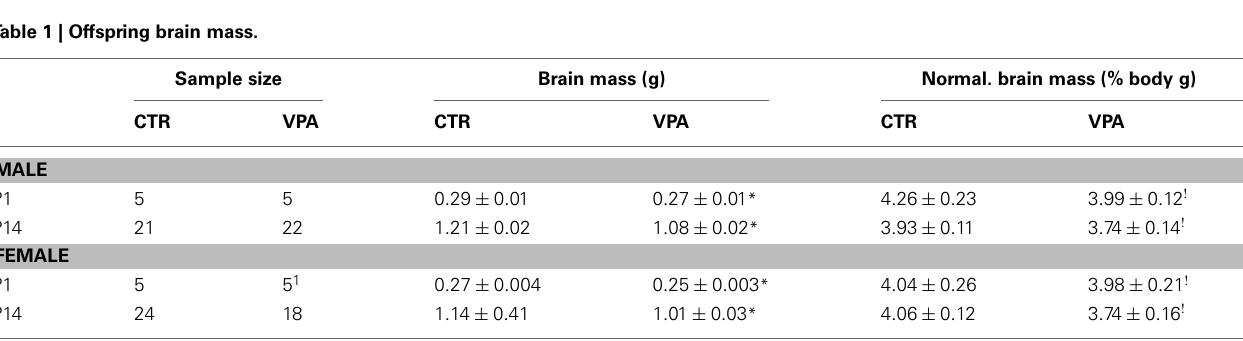
Table 1 | Offspring brain mass. Sample size Brain mass (g) Normal. brain mass (% body